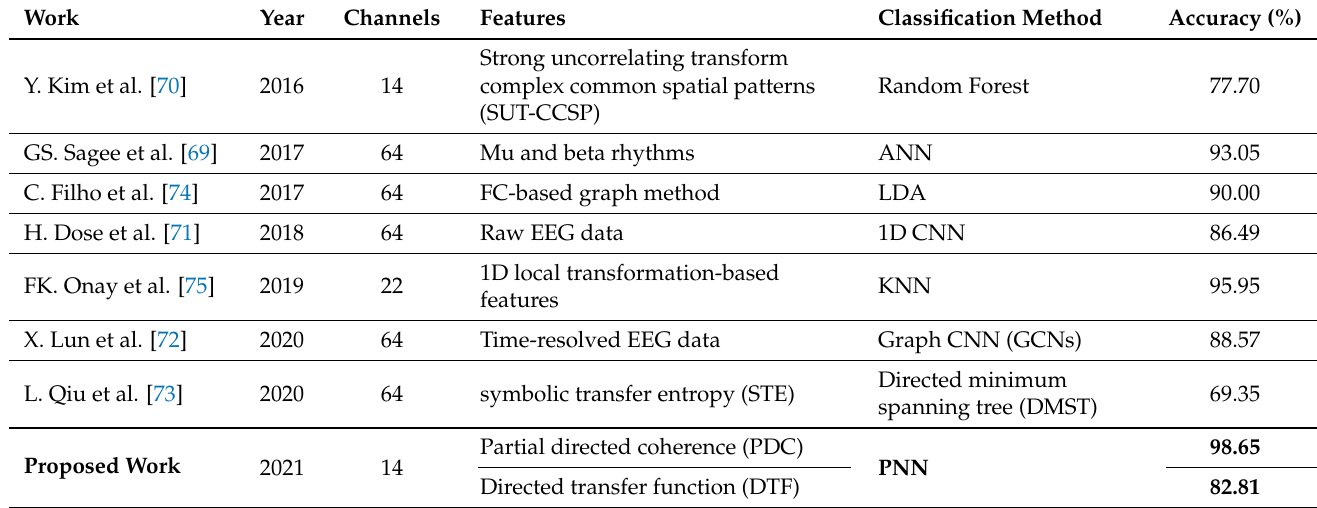
Table 6. Comparison of the classification accuracy with related papers that used the same dataset (the Physionet EEG motor imagery